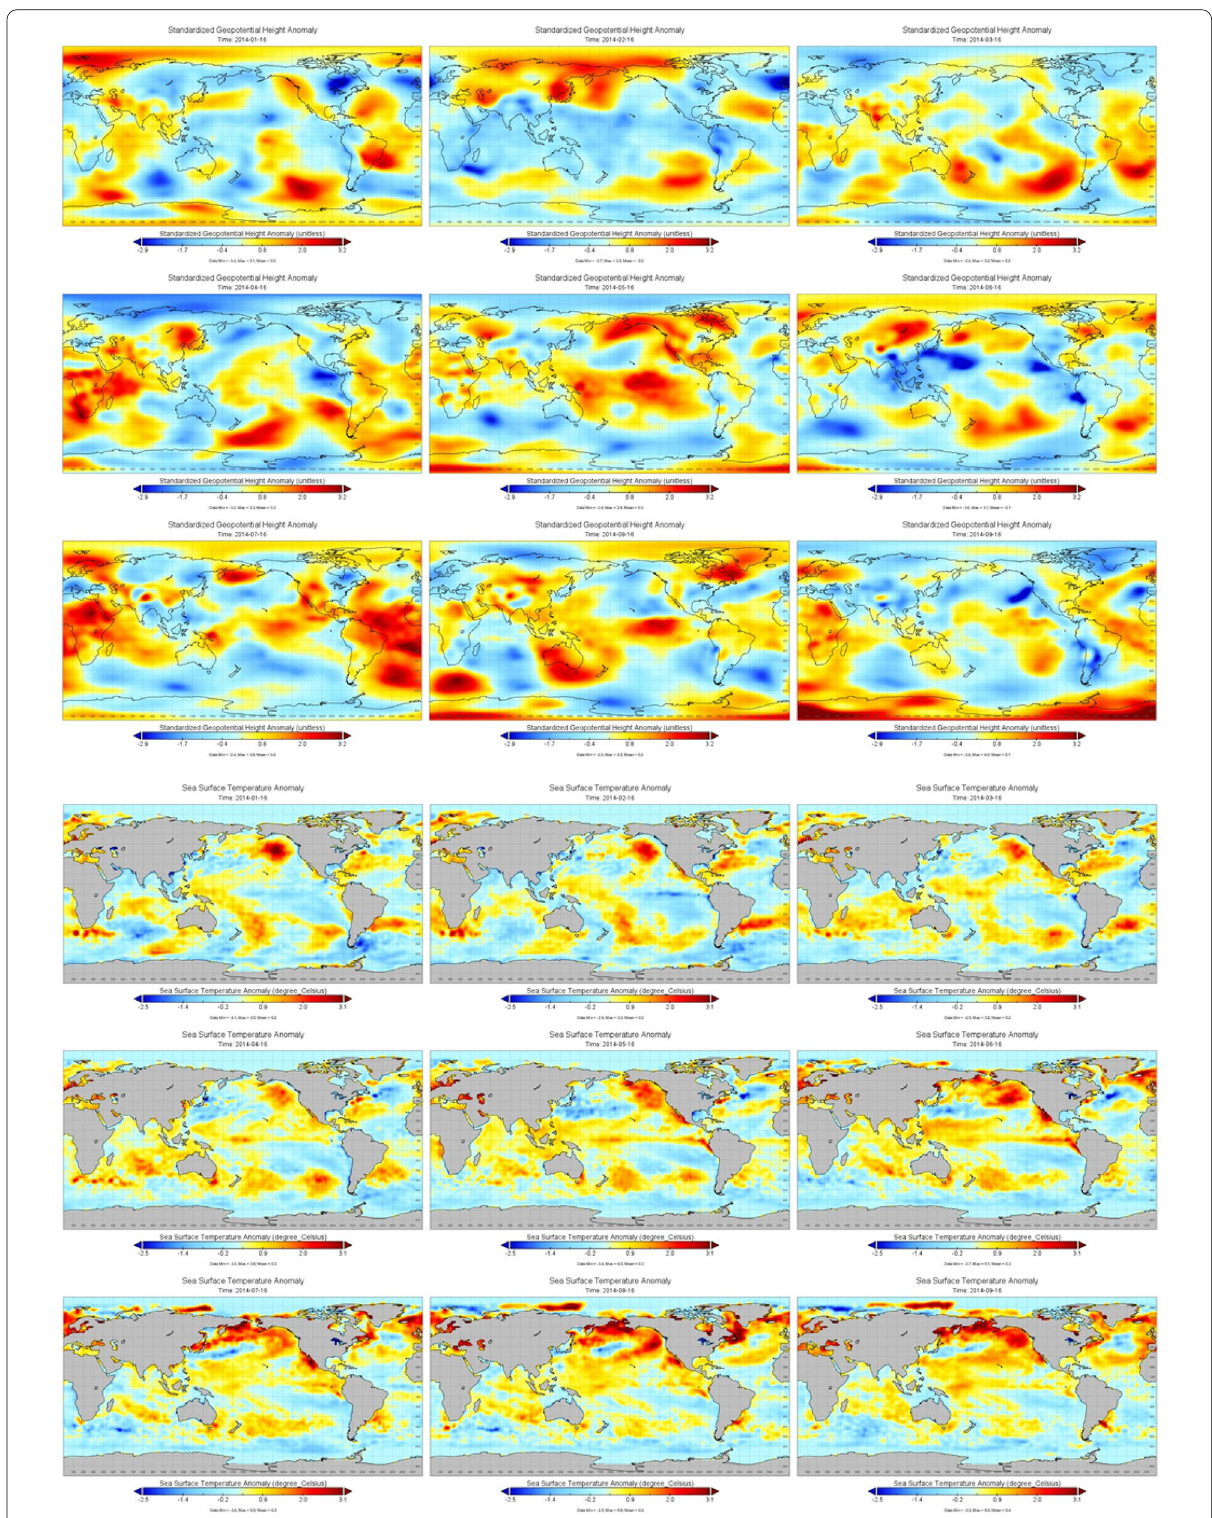
Fig. 21 Global-scale GPH and SST anomaly (January to September